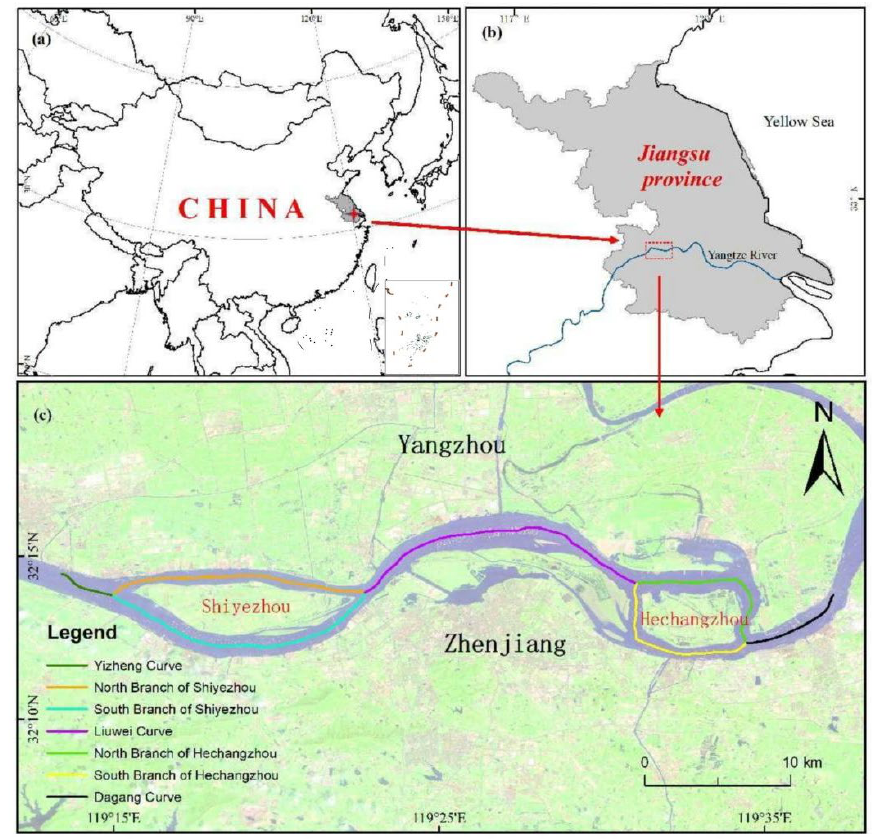
Figure 1. Location of the area of study ( a ) in Eastern China, ( b ) Southwestern Jiangsu Province, the apex of the Yangtze River Delta, and ( c ) the junction of Zhenjiang and Yangzhou.